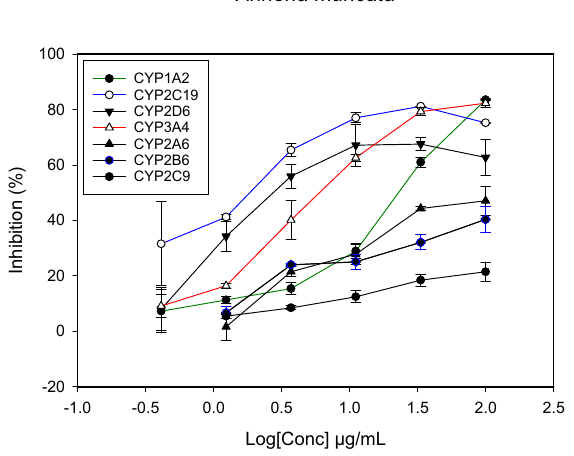
Figure 1. The inhibitory effect of graded concentrations of the extracts of A. muricata on the metabolic activity of cytochrome P450 enzymes.